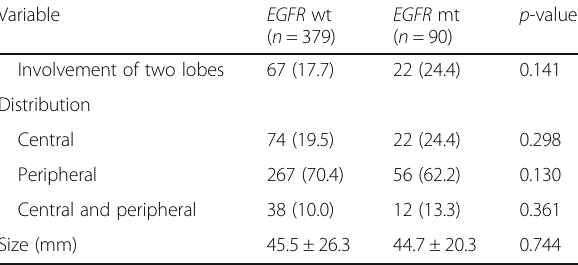
Table 3 Associations between clinicopathological features and EGFR mutational status (Continued)